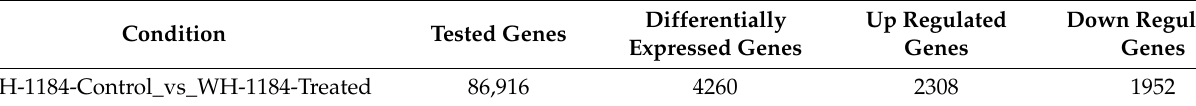
Table 4. Number of expressed genes in control and treated samples.